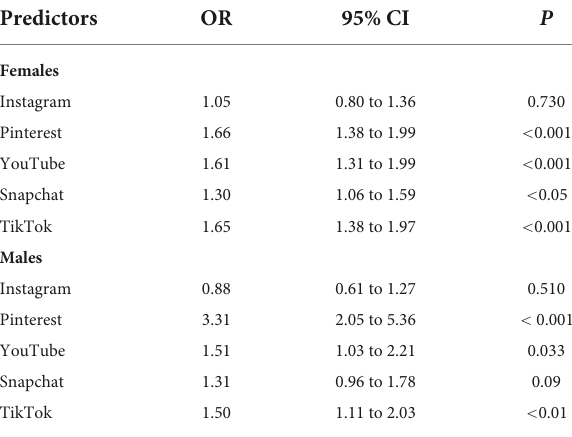
TABLE 4 Odds ratios for self-reporting body image issues (BII) stratified by sex for highly visual social media